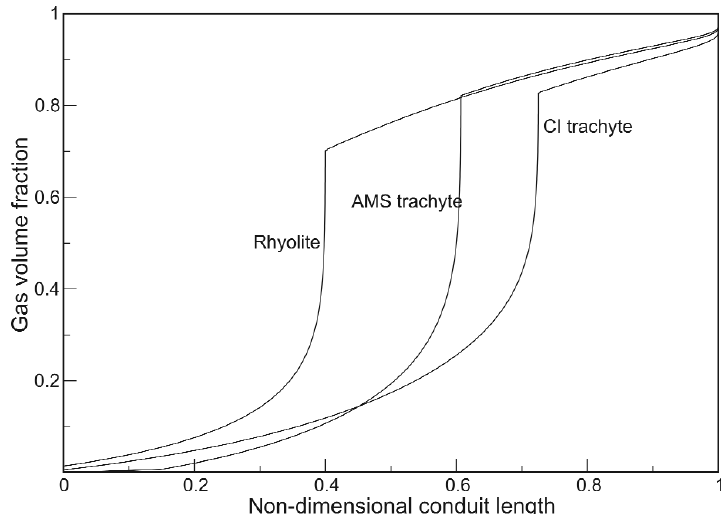
Fig. 1. Calculated distribution of the gas volume fraction along the conduit with the model of Papale (2001). Input parameters are 5 km conduit length, 122.5 MPa stagnation pressure, 6 wt% water content, 60 m conduit diameter and compositions corresponding to that of AMS, CI (Romano et al ., 2003; Giordano et al ., 2004, re- spectively) and a typical rhyolite (Innocenti et al .,